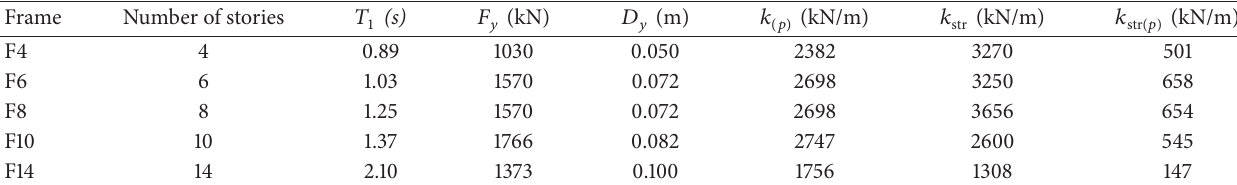
Table 2: Dynamic characteristics of the steel frames with PTED.